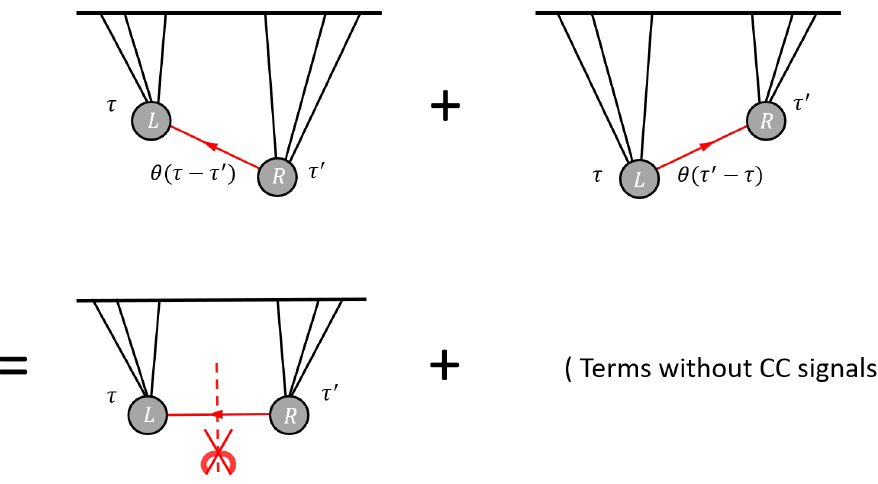
Figure 4 . A schematic diagram showing how to cut the nested integral and extract the CC signals. The first row is the TO diagram before the cut. The second row shows a factorized diagram (the cut result) and a commutator integral, which does not contain the CC signals and can be